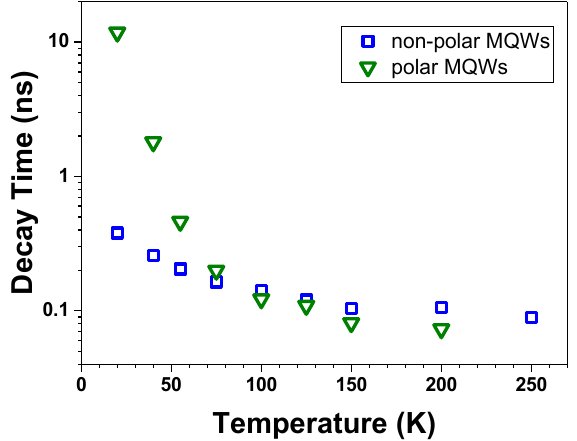
Figure 9. Temperature dependences of PL decay times of the non-polar (blue squares) and polar (green triangles) GaN/AlGaN MQWs, measured at the maximum of the PL.